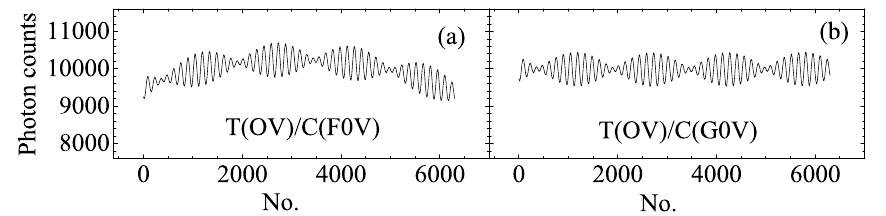
Fig. 3. Determination of spectral type of the comparison star (C) with the extinction correction for synthetic observations assuming different spectral types for the comparison star: (a) the assumed spectral type, F0 V, is wrong, (b) the assumed spectral type, G0 V, is correct. Spectral type O V is assumed for the target star